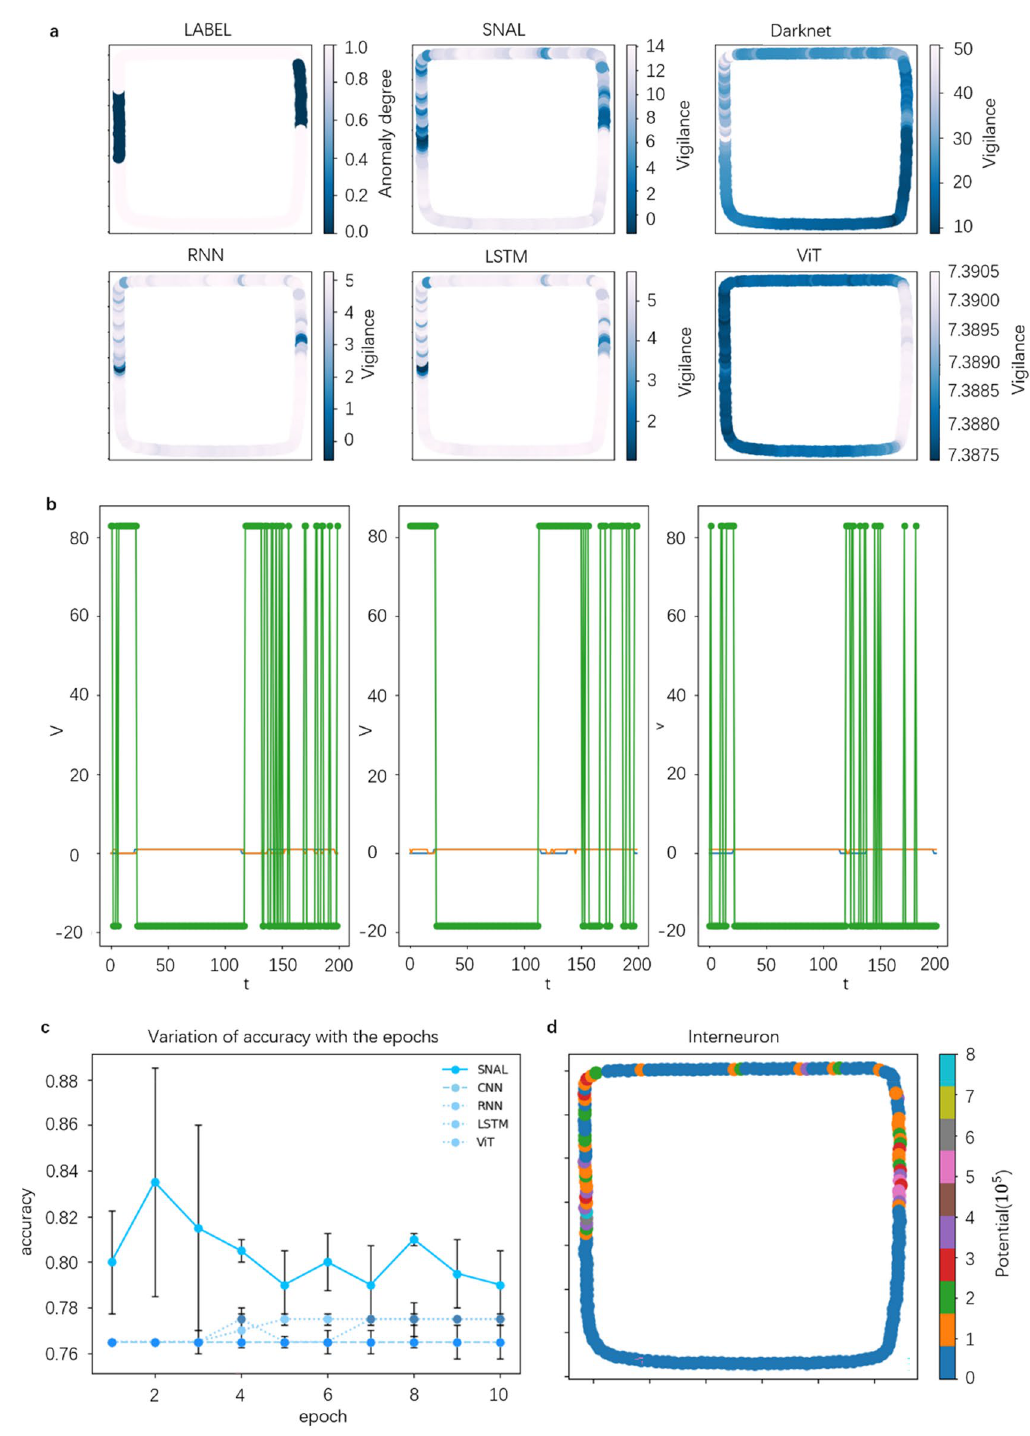
Figure 8. Experimental results and data. ( a ) Vigilance thermodynamic diagram of different network models. The darker the color, the more alert. ( b ) The excitation changes and classification results of modulated interneurons under the threshold of 100,000, 20,000, and 200,000 in common scenes, in which the green line is the excitation potential, the blue line is the label, and the orange line is the classification result (0 represents the abnormal scene and 1 represents the common scene). ( c ) Test accuracy of different network models and different training rounds. It can be seen that the effect of other comparison models has little difference, while the effect of the SNAL model is obviously better than that of the comparison model. ( d ) Thermodynamic diagram of scene eigenvalue change of SNAL model. It can be seen that the scene eigenvalue can distinguish different scenes